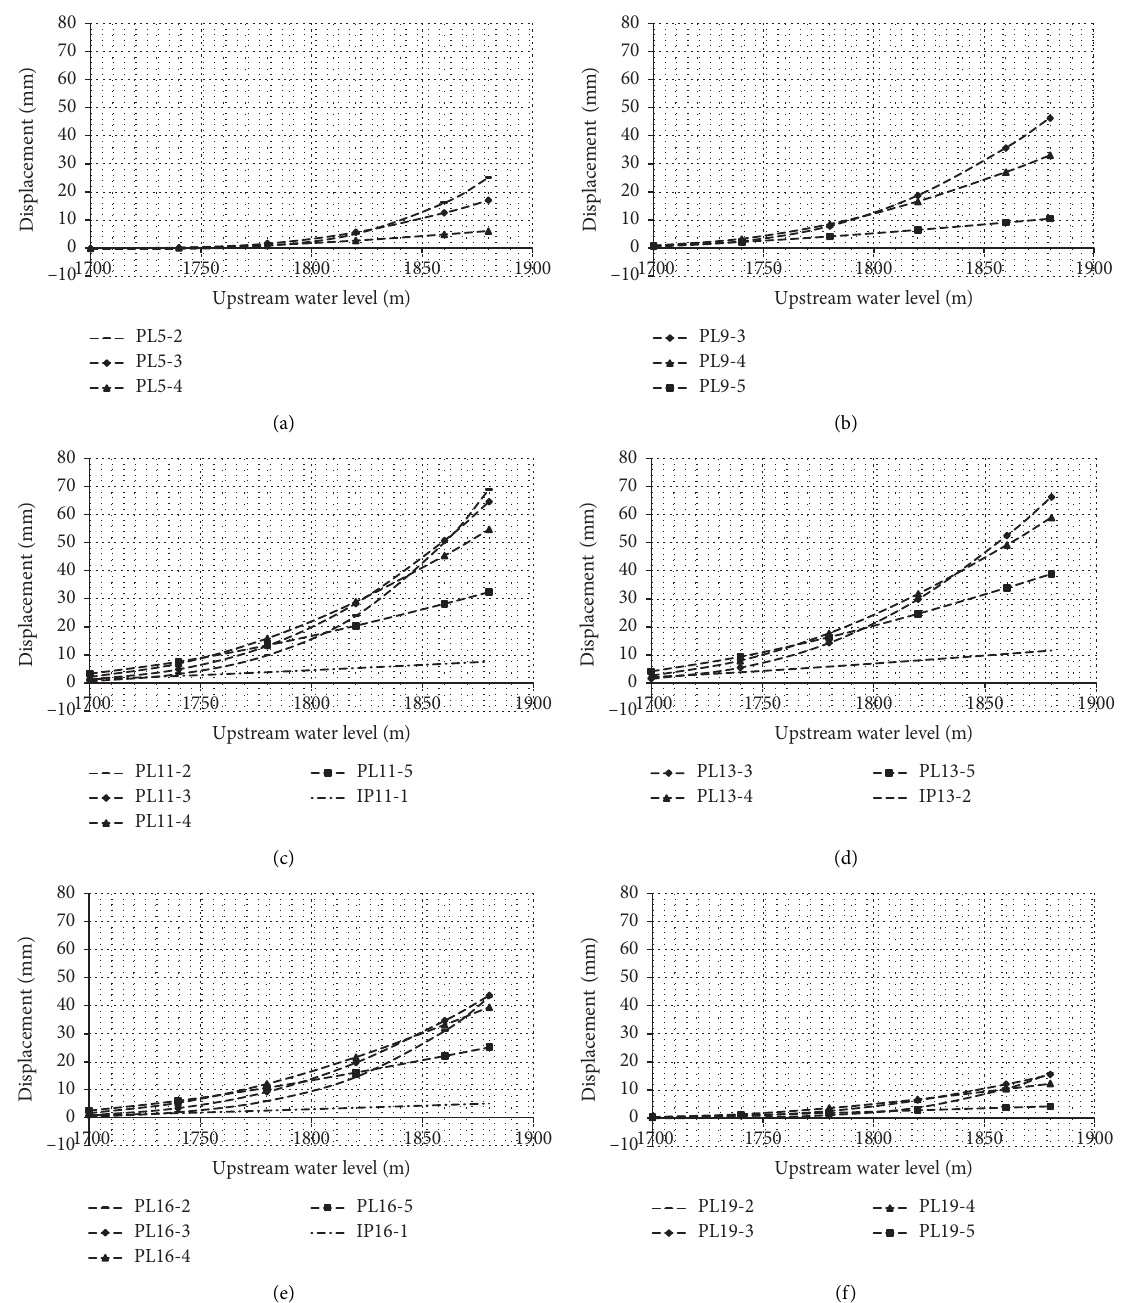
Figure 9: The radial displacement versus upstream water level simulated by finite element method for monitoring points located at vertical line: (a) 5#; (b) 9#; (c) 11#; (d) 13#; (e) 16#; and (f)